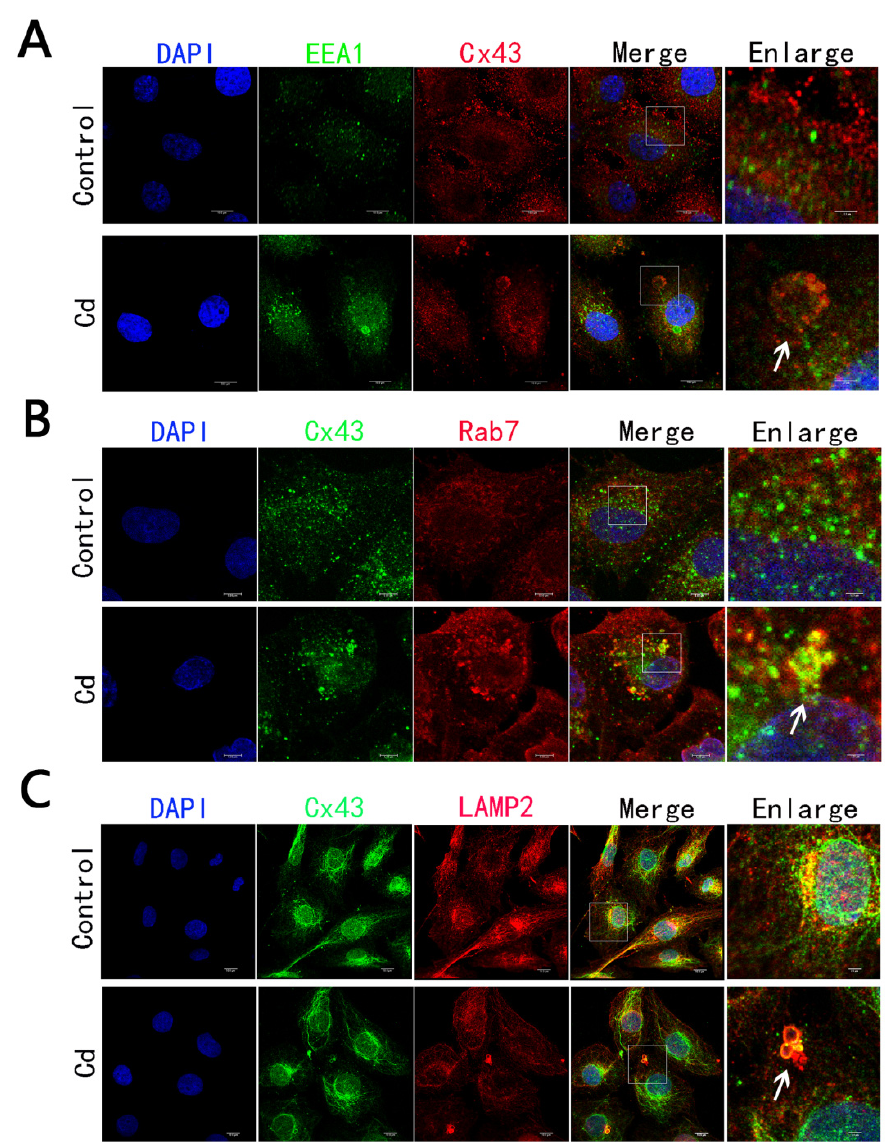
Figure 4. Cx43 interacted with endosomes/lysosomes after internalization: ( A ) Anti-Cx43 antibody (red) is co-stained with antibody against early endosomal marker EEA1 (green), white arrow rep- resents AGJ. Scale bar = 10 µ m; ( B ) Anti-Cx43 antibody (green) is co-stained with antibody against late endosomal marker RAB7a, white arrow represents AGJ. Scale bar = 10 µ m; ( C ) Antibody against Cx43 (green) were co-stained with the anti-lysosomal marker protein LAMP2, AGJ was represented by the white arrow. Scale bar = 10 µ m.